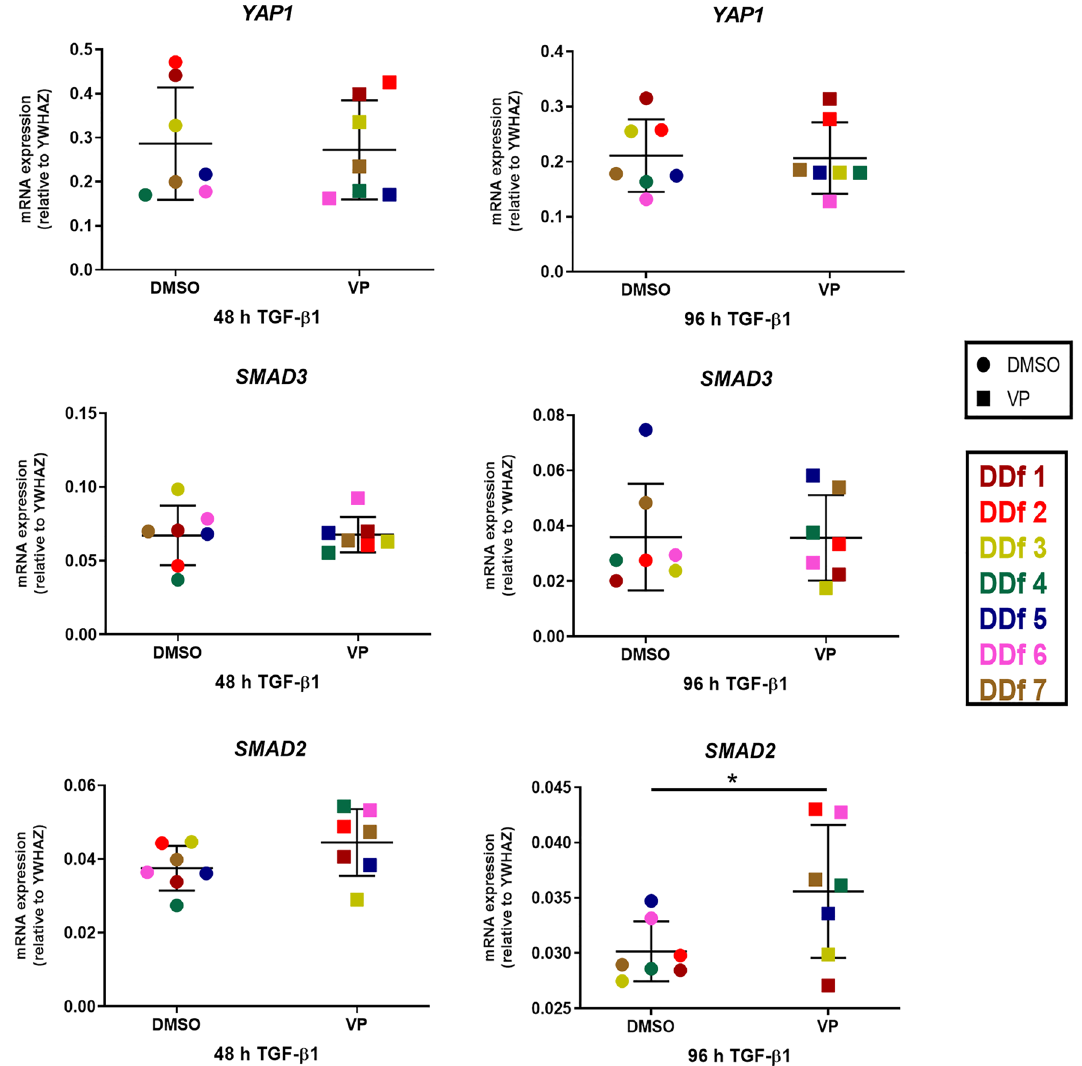
Figure 8. Effect of VP treatment on TGF-β/Hippo pathway downstream effectors. Relative mRNA expression of YAP1, SMAD2 and SMAD3 after stimulation with TGF-β1 for 48 h followed by 48 h in the presence or absence with VP, or after stimulation with TGF-β1 for 96 h but in the last 48 h in the presence or absence of SERPINE1 is an inhibitor for plasmin-mediated MMP activation 41,42 . VP not only attenuated the synthesis of col- lagen, it also attenuated SERPINE1 levels, thus facilitating plasmin-mediated MMP activation (and consequently collagen breakdown). PLOD2 encodes for lysyl hydroxylase 2, an enzyme involved in the formation of a specific cross-link type of collagen, making collagen more resistant towards collagenases 7,43,44 . We found that VP also decreases mRNA levels of PLOD2 , thus making the deposited collagen more susceptible towards collagenases. It is well established, that myofibroblasts are at the heart of fibrosis: these are the cells that produce the collagen that replaces functional tissues into fibrotic tissues. Myofibroblasts are characterized by the presence of α-SMA stress fibers; these fibers are absent in fibroblasts. Interestingly, VP did not affect mRNA levels of ACTA2 (encod- ing for α-SMA), only modestly affected protein levels (as revealed by Western blotting), and no change was seen in the percentage α-SMA positive cells in some of the patients. Despite this, all subjects showed a major decrease in e.g. collagen levels. Thus, although the cells would still be classified as myofibroblasts based on the presence of α-SMA stress fibers, the overall phenotypical properties of the cells are that of a fibroblast. Although a full inhibition of myofibroblasts can be achieved by e.g. using higher concentrations of VP 29,36,45 , such concentrations might not be necessary to achieve the desired outcome (i.e. inhibition of extracellular matrix accumulation). CCN2 (= CTGF ) gene expression is induced by TGF-β1 stimulation and is a direct target of the YAP/TAZ- TEAD complex 46–48 . An inhibition of YAP by VP should therefore result in lower mRNA levels of CCN2 . Our results show that VP treatment indeed decreases CCN2 gene expression both in non-stimulated and stimulated cells, which is in line with other studies 18,29,34,37,39,45 . In our study, VP did not influence the gene expression (mRNA level) of the myofibroblast marker ACTA2 in 48 h or in 96 h stimulated cells. From the five in vitro studies that report a decrease in ACTA2 gene expression,